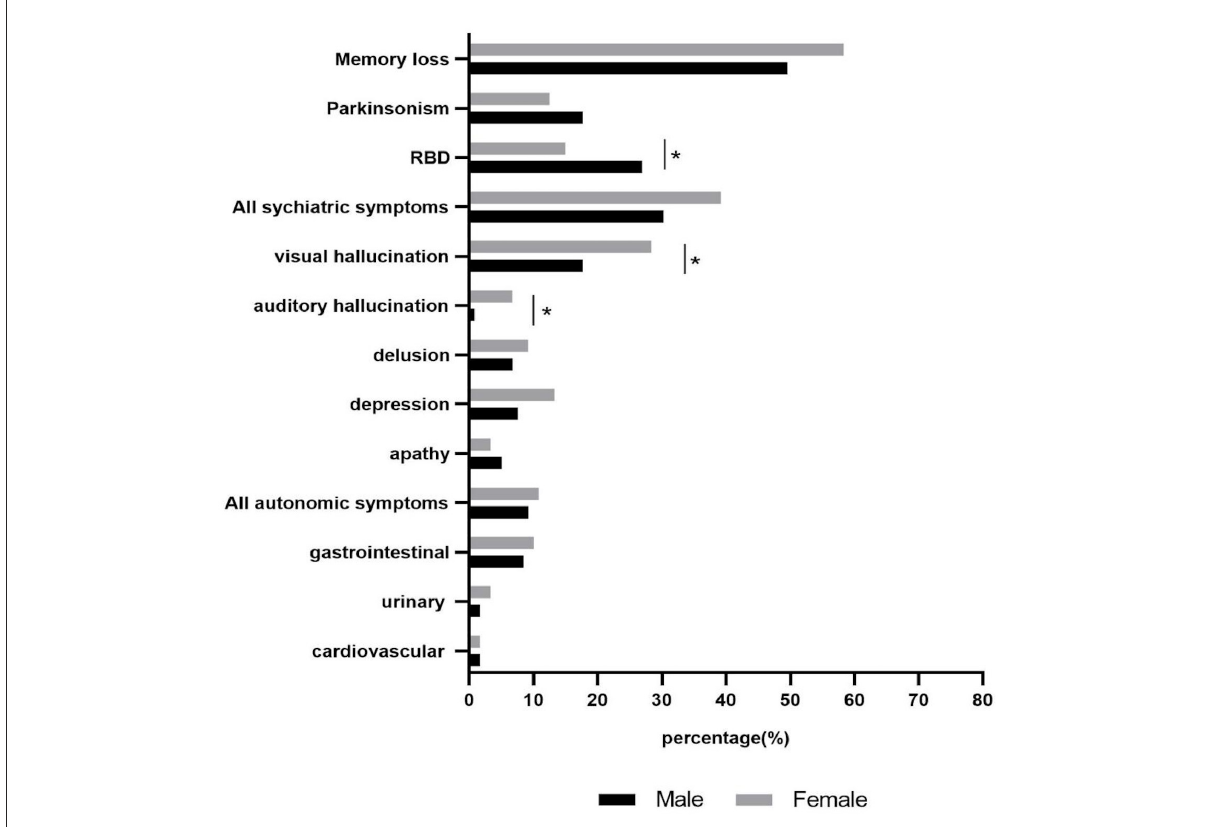
FIGURE1 Gender differences in initial symptoms of patients with DLB. * The results showed significant differences between male and female. * p < 0.05.